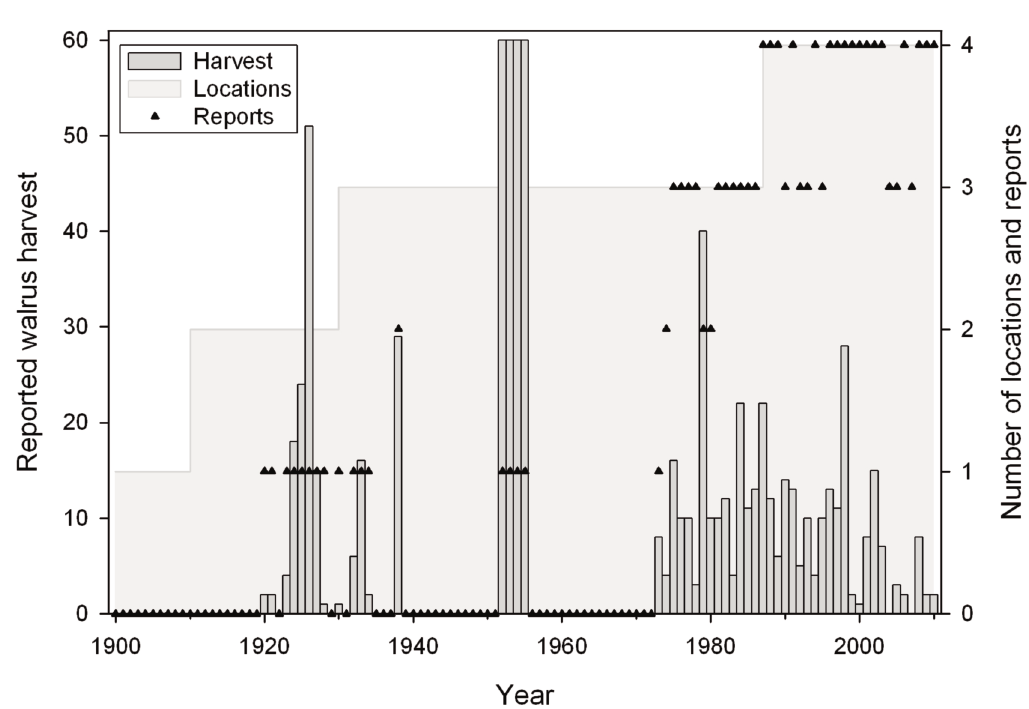
Fig. 24. Catches by Inuit and shore-based traders, and community reporting rates, from the Canadian Low Arctic walrus population,